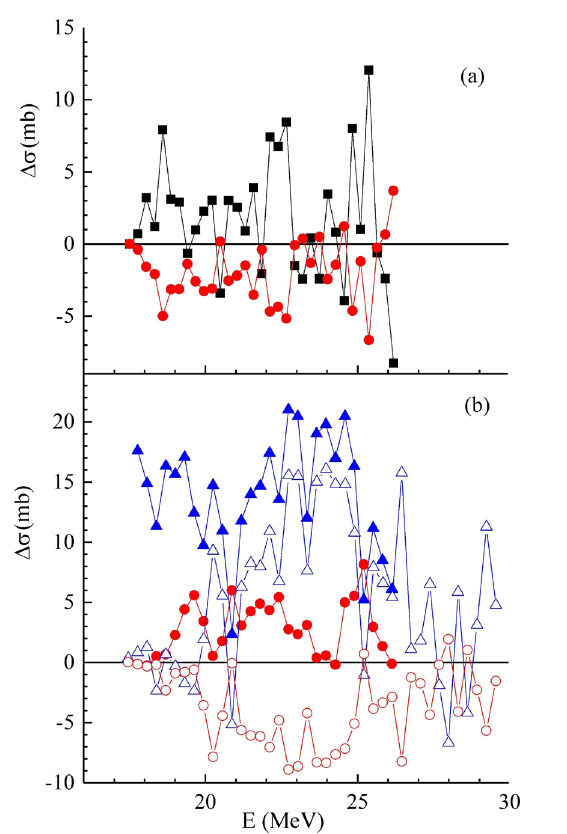
σ exp between the eval- Figure 5. The di ff erences ∆ σ = σ e v al − uated [15] and the experimental cross sections for 75 As: (a) for data [24] (squares – ( γ, 1 n ), circles –( γ, 2 n )), (b) for data [23] (full triangles – ( γ, 1 n ), full circles – ( γ, 2 n )), for corrected (look further) data [23] (open triangles – ( γ, 1 n ), open circles – ( γ, 2 n )). Lines –calculated [16, 17] ( γ, 1 n 1 p ) reaction